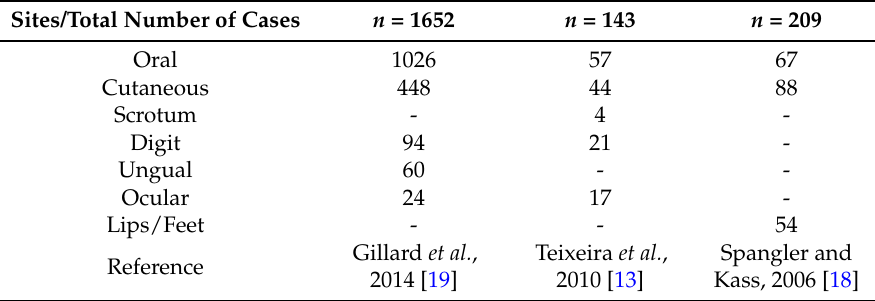
Table 1. Common sites of malignant melanomas in